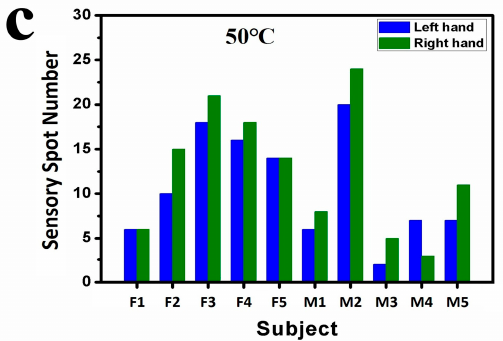
Figure 5. Numbers of sensory spots on the backsides of hands and fingers of 10 subjects in the second round of experiments. Numbers of sensory spots responded to ( a ) at 40.0 °C and ( b ) at 45.0 °C on the back of hands; ( c ) Numbers of sensory spots responded to at 50.0 °C on the backsides of fingers.